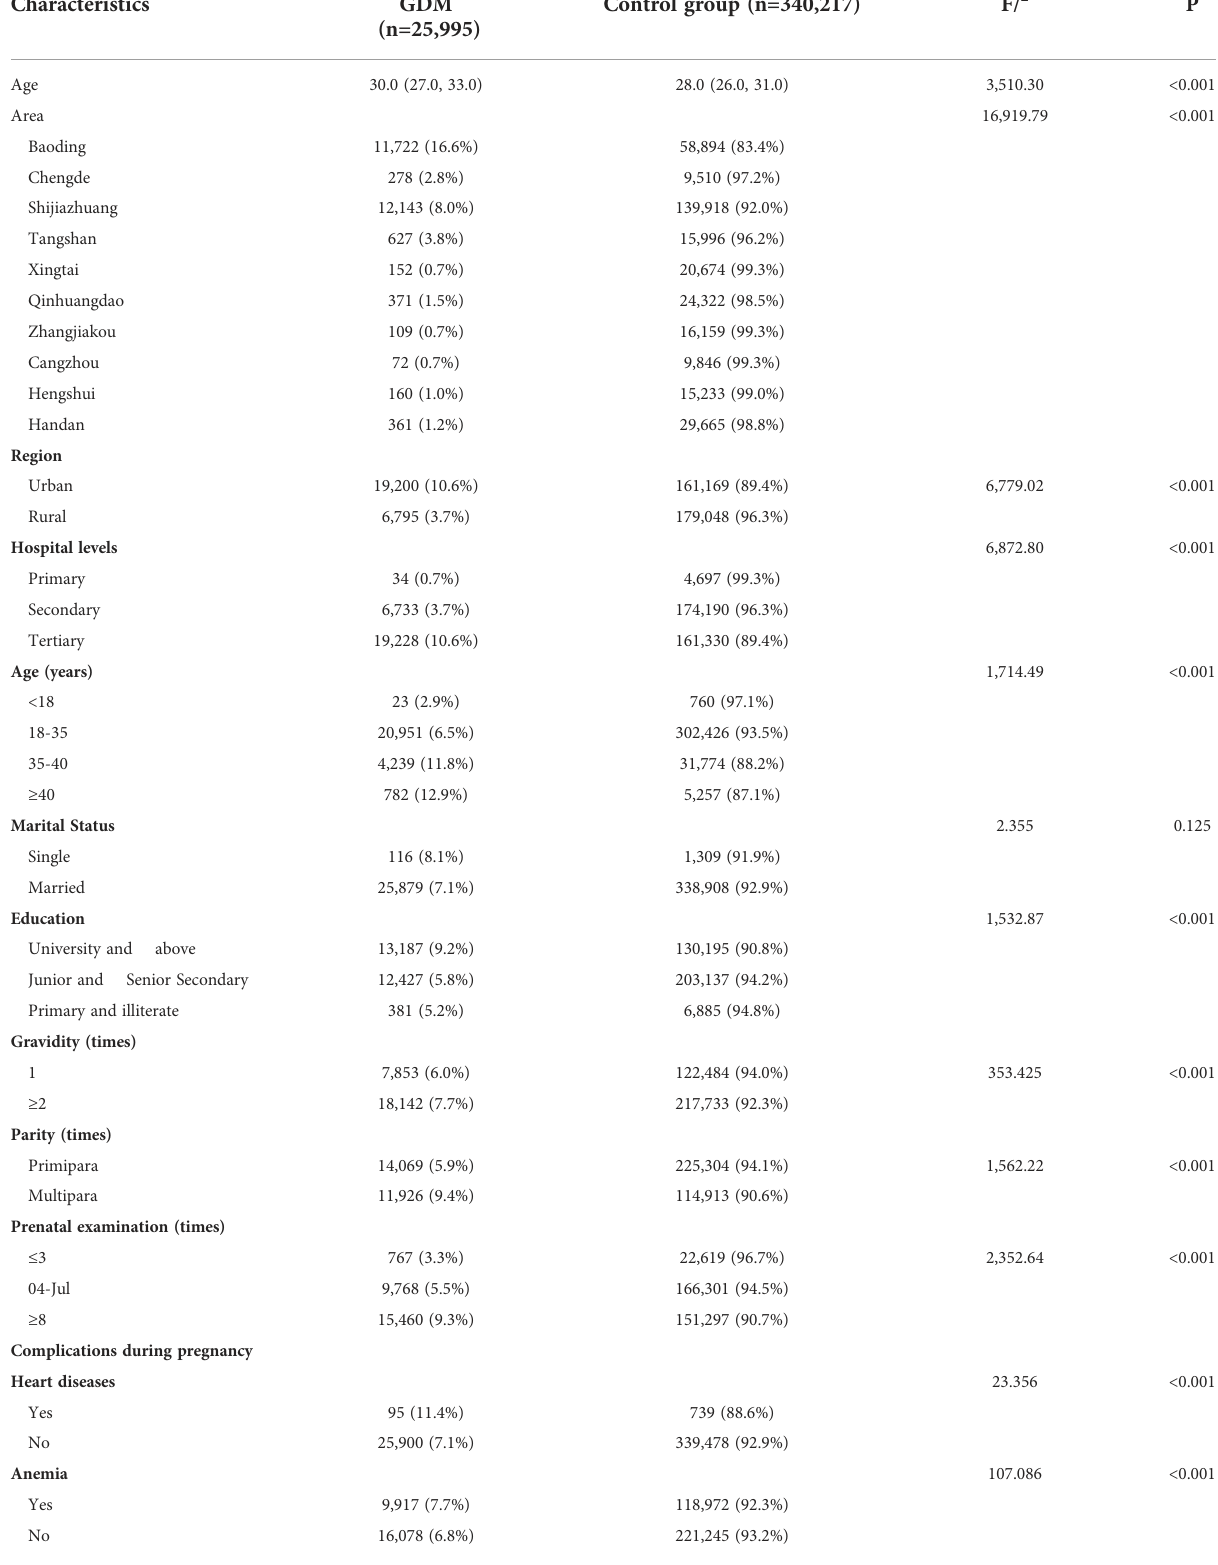
TABLE 1 Maternal characteristics of individuals with singleton live births and GDM in Hebei from 2014 to